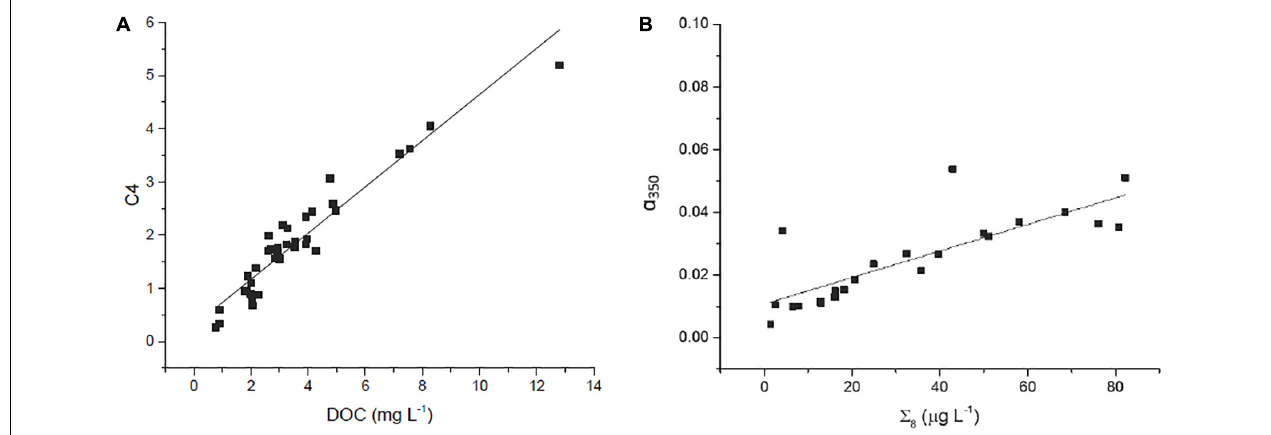
FIGURE 5 | Relationship between (A) T peak region EEM (C4) and DOC ( r 2 = 0.91, p < 0.001, n = 39) and (B) (cid:54) 8 and α 350 ( r 2 = 0.65; p < 0.001, n = 23).